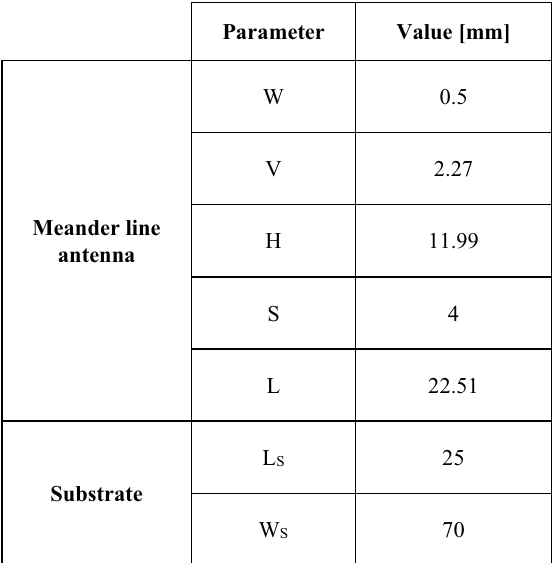
Table 2. Optimal parameters of the proposed RFID TAG at